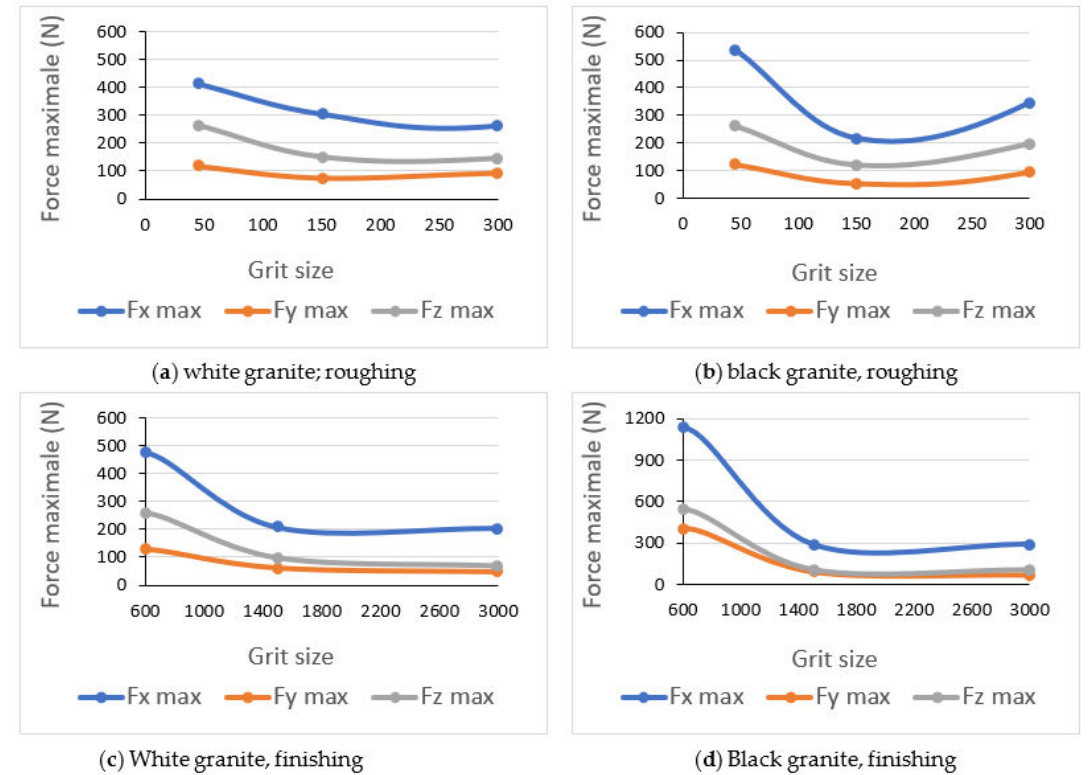
Figure 20. Maximum cutting forces F x , F y , and Fz as a function of abrasive grit sizes while grinding: ( a ) Roughing white granite, ( b ) Roughing black granite, ( c ) Finishing white granite and ( d ) Finishing black granite; (Vs = 2500 rpm, f = 1000